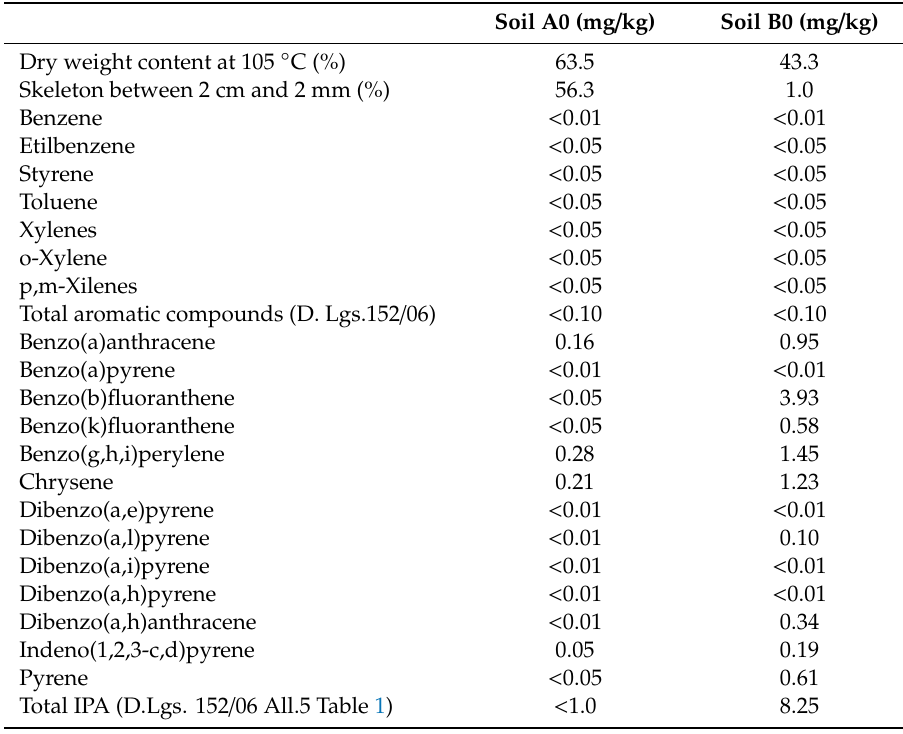
Table 1. Chemical analysis on soils A0 and B0.